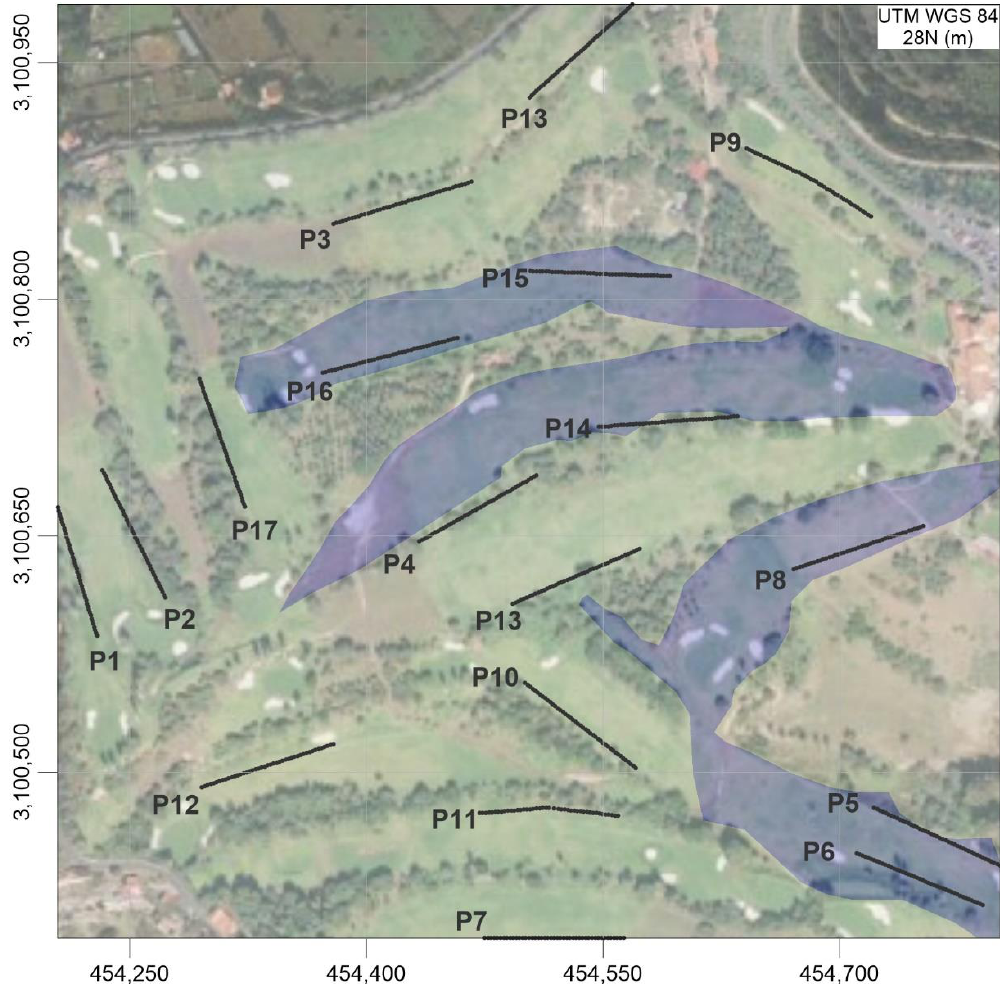
Figure 2. ERT profiles location (dark grey lines) and transported soil (purple